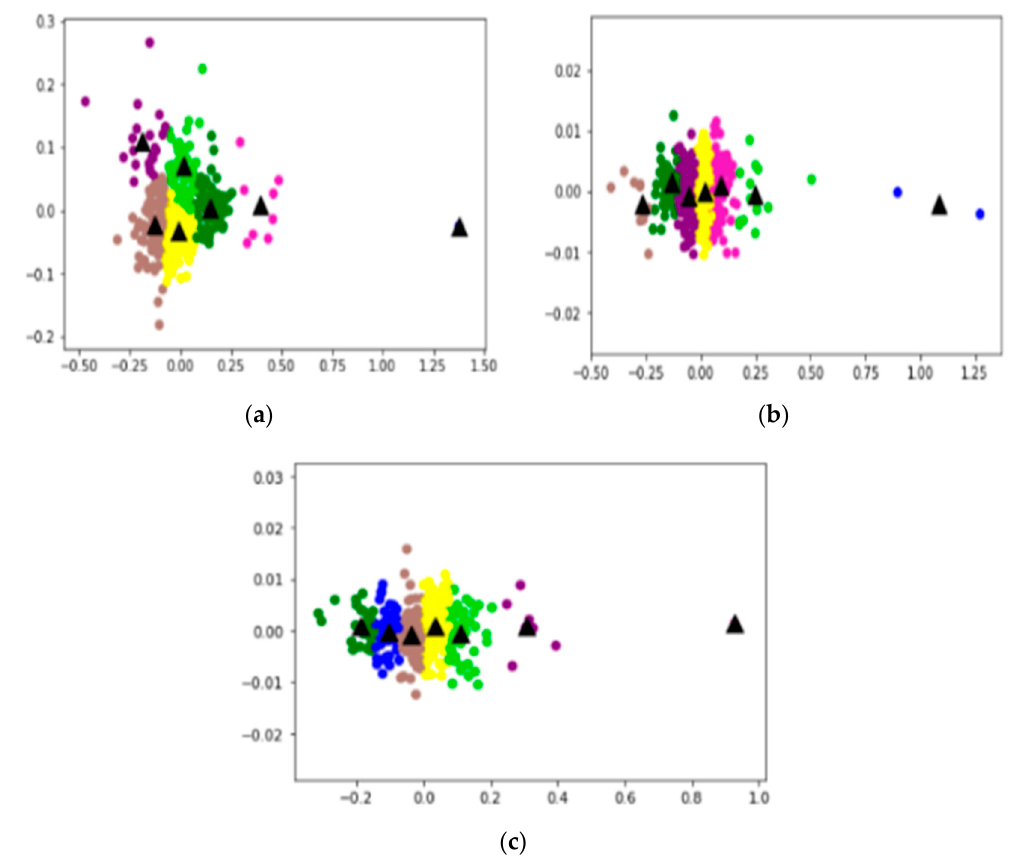
Figure 3. K-means++ clustering of: ( a ) DM, ( b ) TB and ( c ) thyroid.